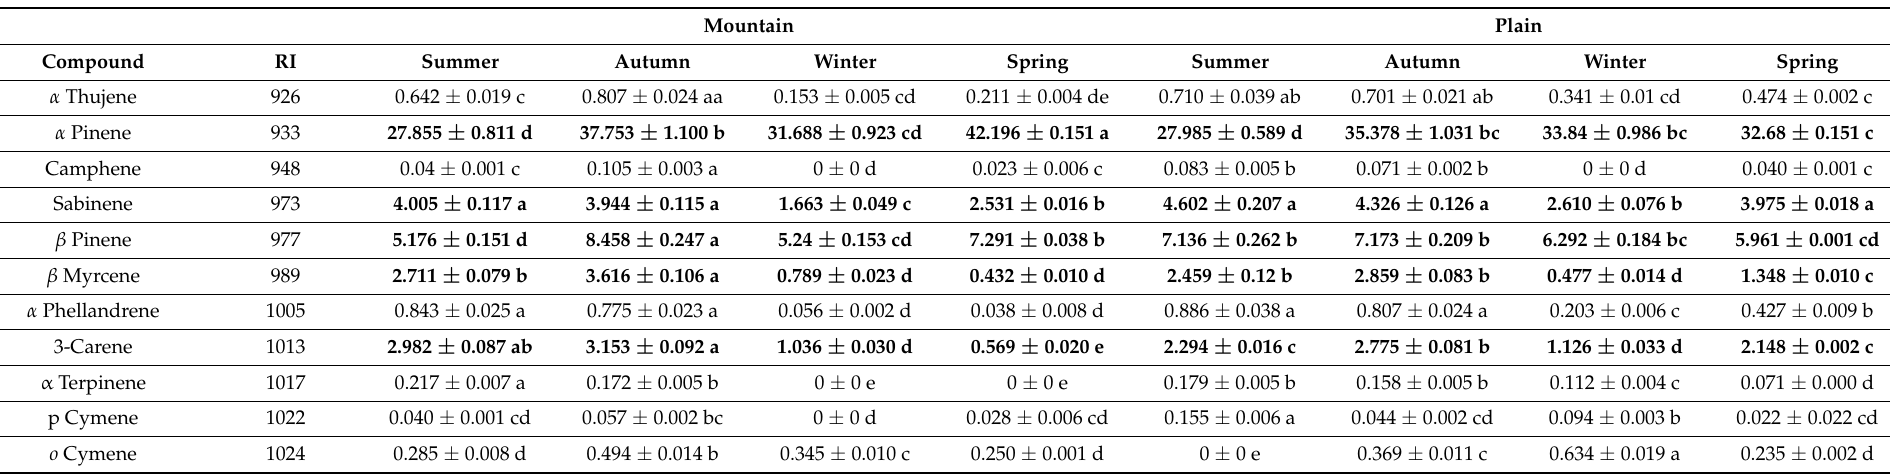
Table 6. Chemical composition (%) of essential oils of sideritis